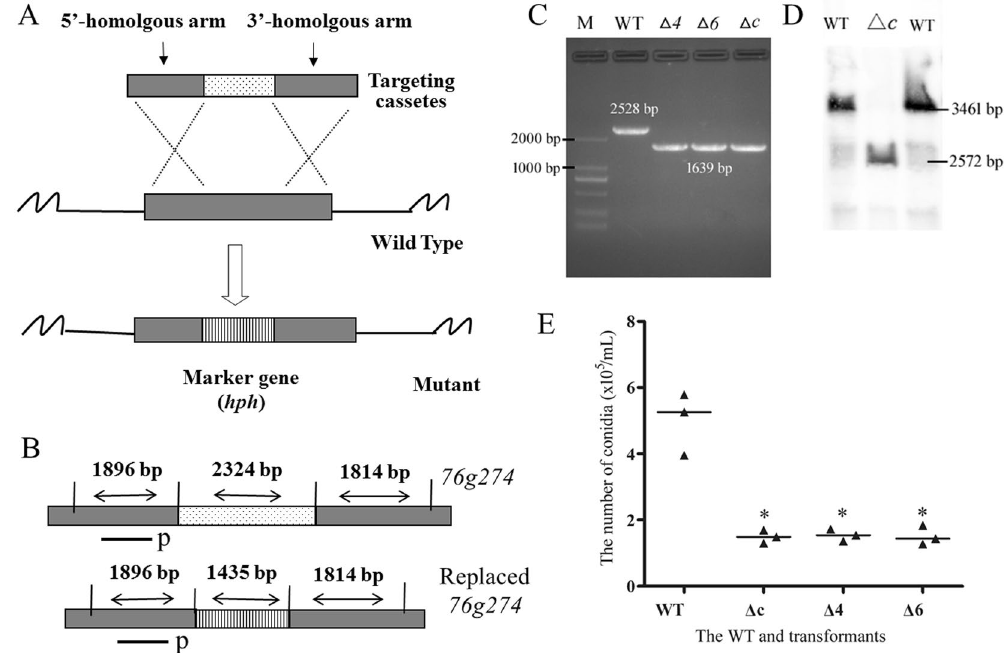
Figure 7. Disruption of gene 76g274 in A. oligospra and Southern blotting analysis. ( A ) The sketch map of gene knock-out by homologous recombination. ( B ) Replacement and Southern blotting analysis of gene 76g274 . The length of fragments was marked in figure and p indicated the probe site. ( C ) The PCR verification of WT and three mutants. ( D ) The Southern blotting analysis of WT and mutant Δ c . ( E ) Comparison on conidia number of WT and three mutants. * P < 0.05 versus WT. The horizontal bars depict the median, and data are presented as suggested by Weissgerber et al . 58 and Klaus 59